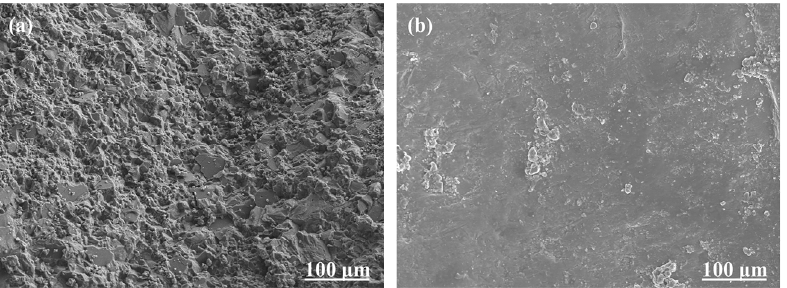
Figure 6. ( a , b ) are the SEM images of the limestone before and after 7 polishing cycles,